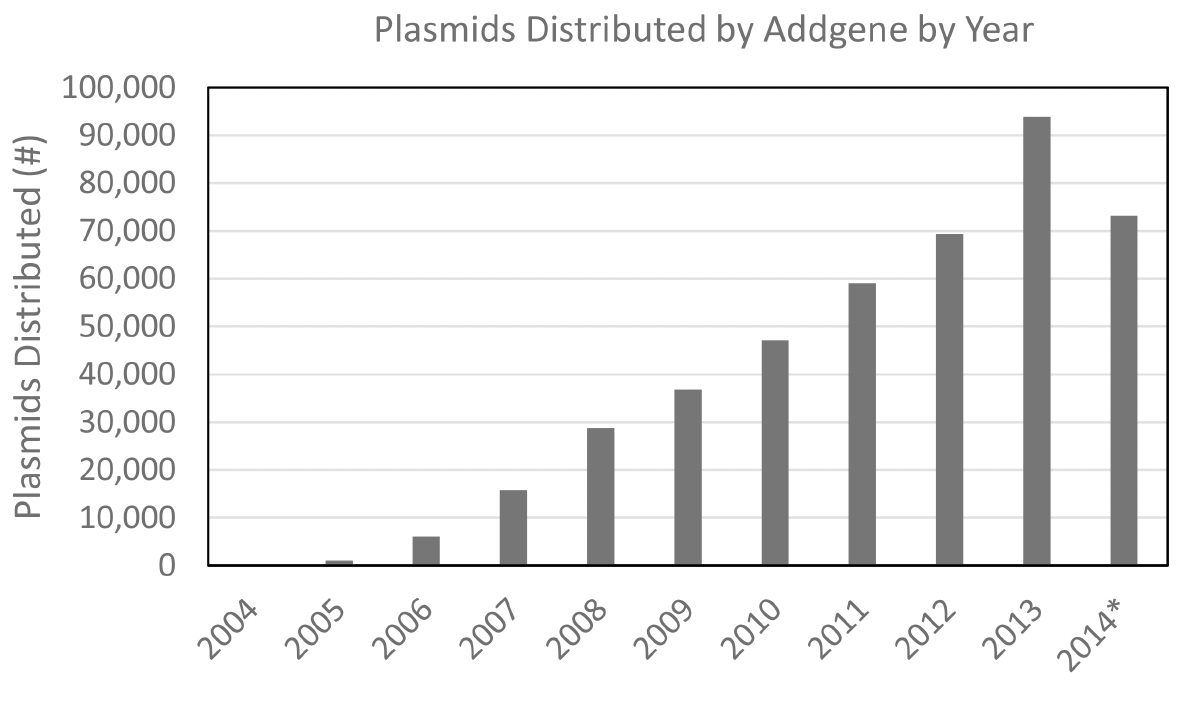
Figure 2. Distribution of plasmids from the Addgene library. The total number of plasmids and kits distributed by Addgene each year. For this analysis, multiplasmid kits were counted as ‘‘1’’ plasmid distribution. *2014 total reflects the number of distributed plasmids as of August 20, 2014.